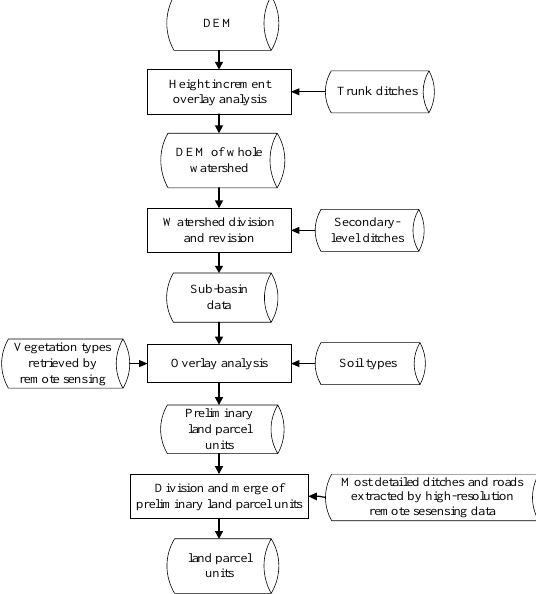
Figure 2. Technical route of land parcel unit division in the irrigation